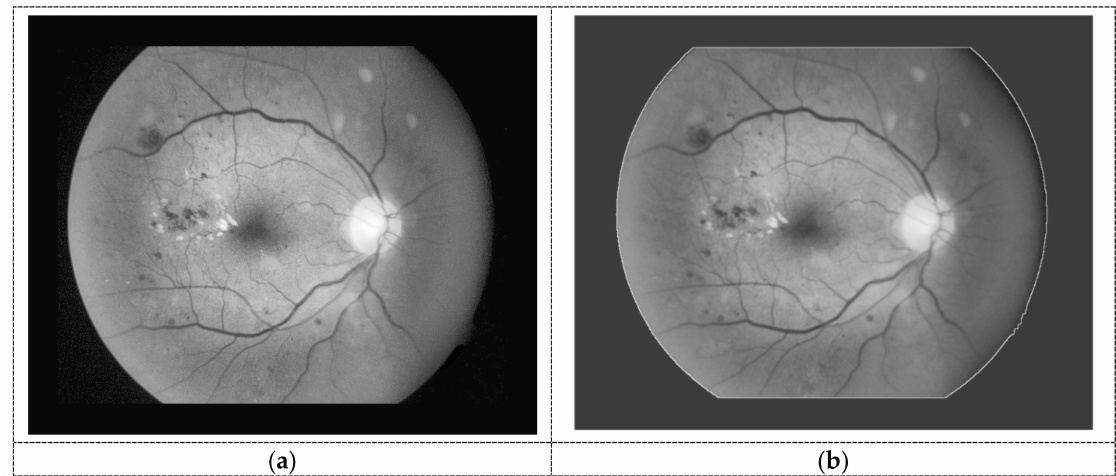
Figure 4. Image sharpening ( a ) non-linear unsharp masking, ( b ) hand-crafted image for feature